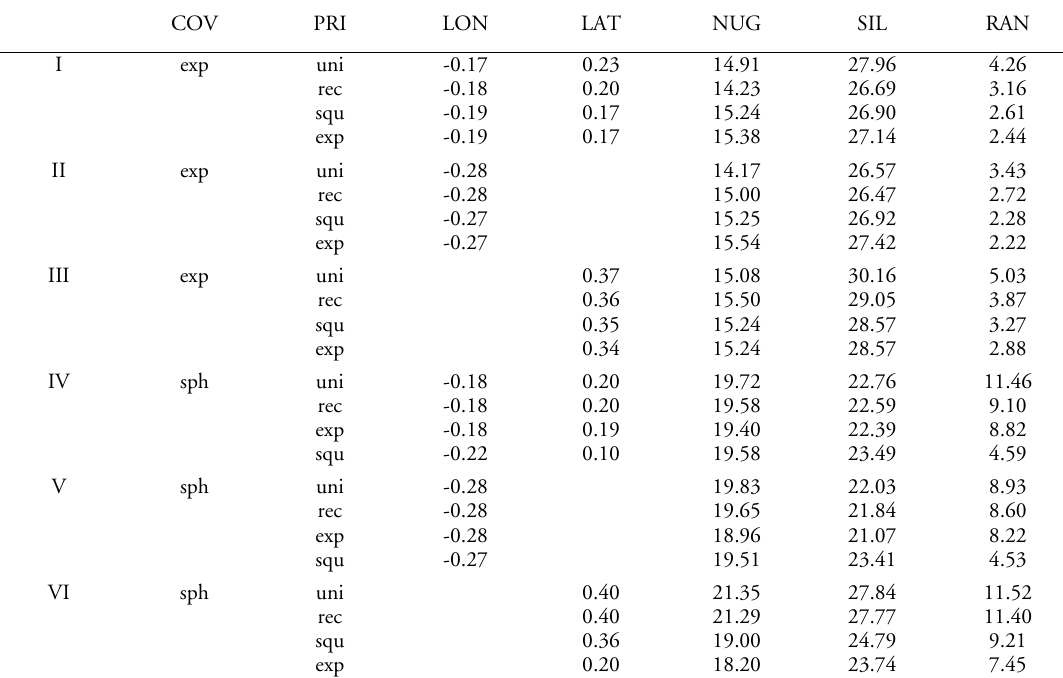
Six different spatial models: Bayesian posterior estimates of fixed effects (LON and LAT) and covariance parameters (NUG, SIL, RAN) for four different choices of the prior distribution of the range parameter (PRI) and two alternative specifications of the covariance structure (COV). COV PRI LON LAT NUG SIL RAN exp uni -0.17 rec squ exp